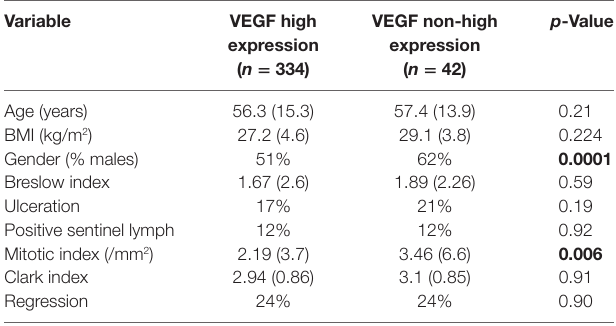
Bold fond indicates p < 0.05. TaBle 4 | Comparisons between expression groups of vascular endothelial growth factor (VEGF) regarding sleep-disordered breathing variables and intermittent/continuous hypoxia indicators.